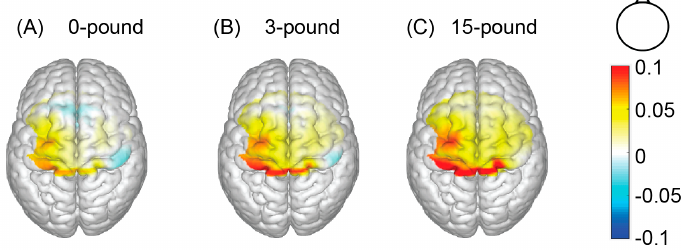
Figure 4. Averaged beta on a standardized brain model (n = 14). ( A ) The 0—pound condition, in which a typical contralateral activation pattern was observed. ( B ) The 3—pound condition, in which BA4 and BA6 show higher activation levels. ( C ) The 15—pound condition, in which BA4 and BA6 exhibited the highest activation among the three conditions.